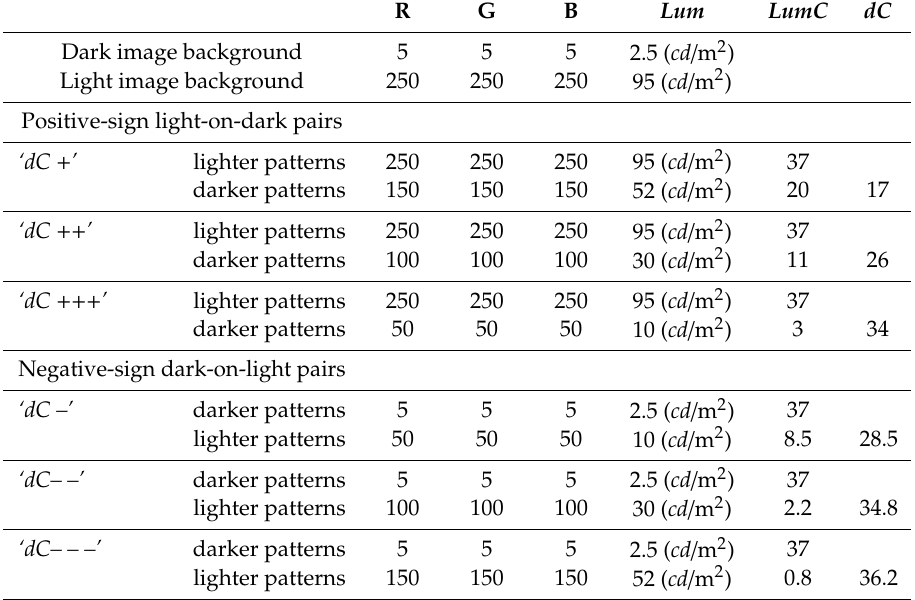
Table 1. RGB values and luminance parameters ( Lum ) in candela per square meter ( cd / m 2 ) for patterns with positive (light on dark) and negative (dark on light) contrast sign (polarity). Lighter and darker patterns were paired in the image configurations (Figure 1) and displayed to the left and to the right. LumC corresponds to Weber contrasts, calculated as given in (1). The di ff erence between the Weber contrasts ( dC ) of two patterns in a pair determines the perceived di ff erence in relative pattern depth. R G B Lum LumC